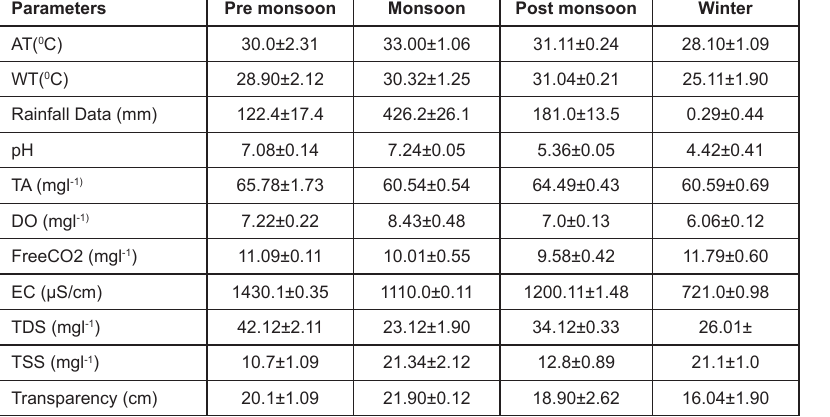
Table 3. Seasonal variation of physico-chemical characteristics (Mean ± SD) of water of the pond.